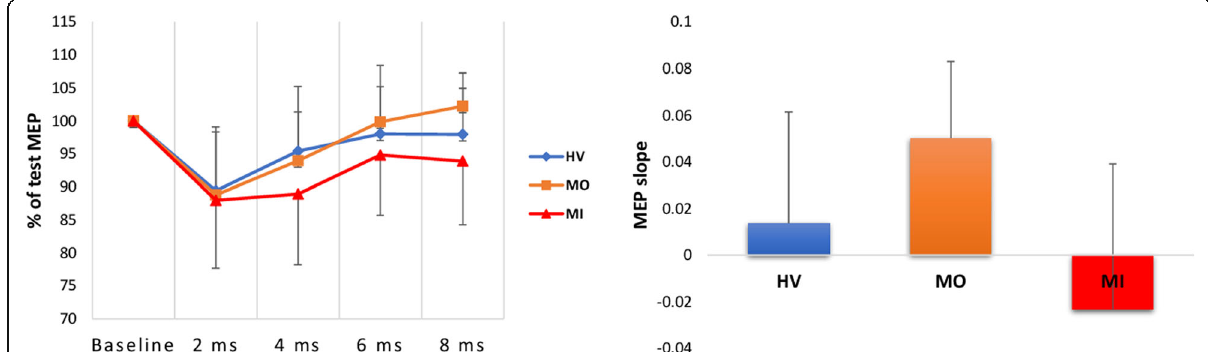
Fig. 1 Left panel: Line plots of short-latency afferent inhibition (SAI) at the various interstimulus intervals in healthy volunteers (HV) and in migraine patients recorded between (MO) or during (MI) an attack. Right panel: Bar chart of the MEP slope (mean + sd) of the regression line between the unconditioned MEP amplitude and the 4-conditioned MEPs in the same subject groups. MEP = motor evoked potential